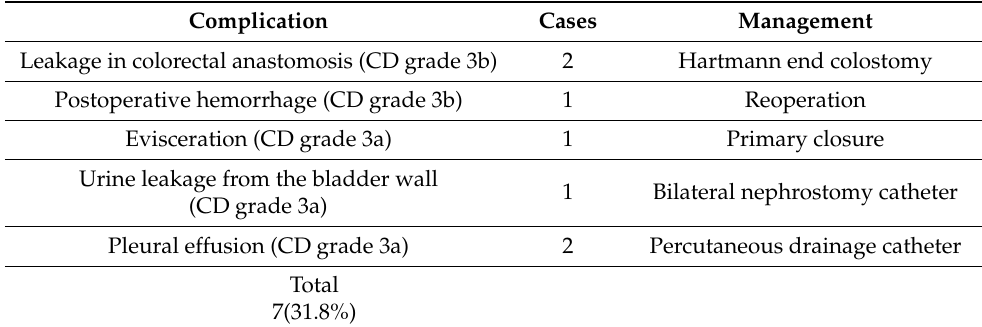
Table 4. Grade 3Clavien–Dindo (CD) complications classification and management.